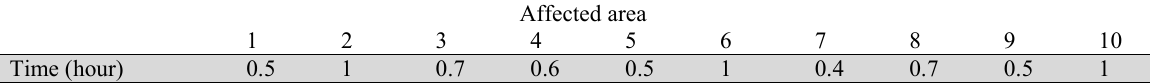
Acceptable times to satisfy evacuating demands of demand points